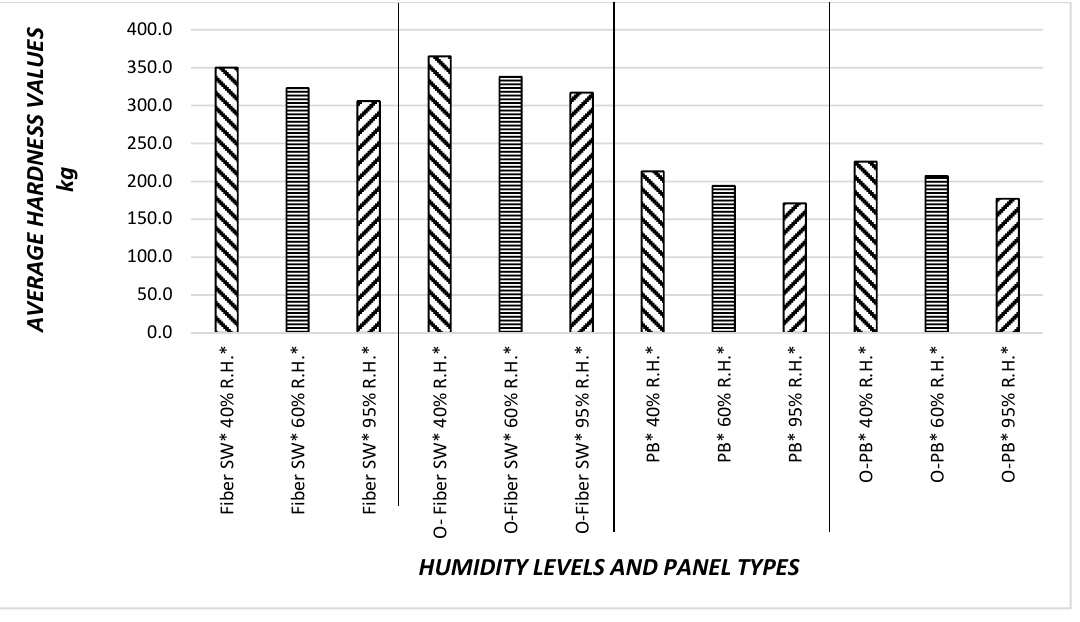
Figure 10. Average hardness values of composite panels.